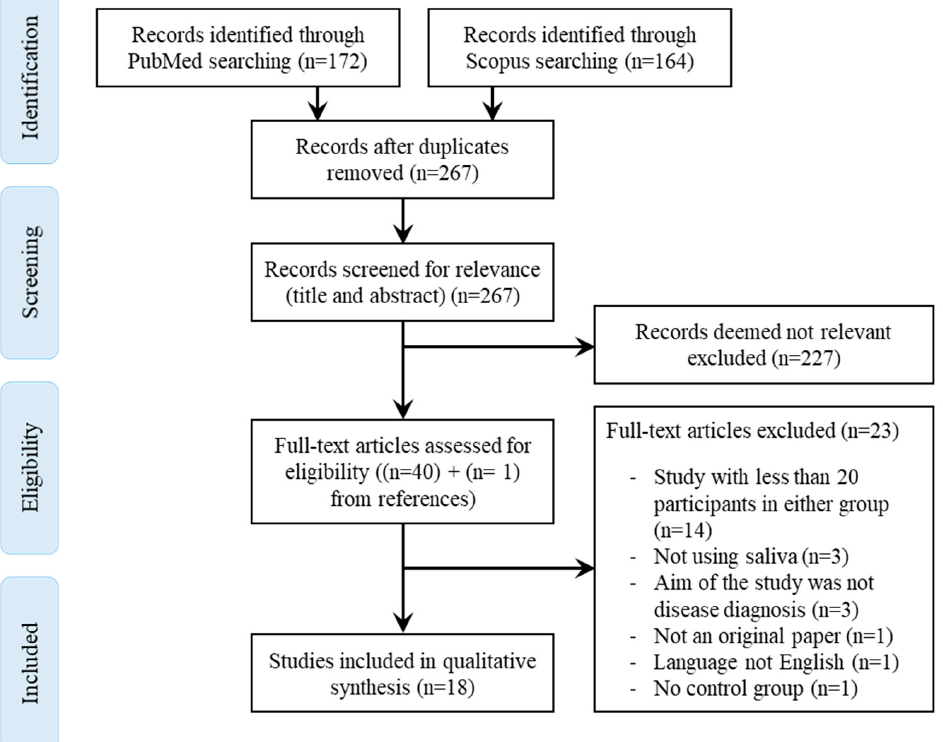
Figure 1. PRISMA (Preferred Reporting Items for Systematic Reviews and Meta-Analyses) diagram for the selection of relevant studies.